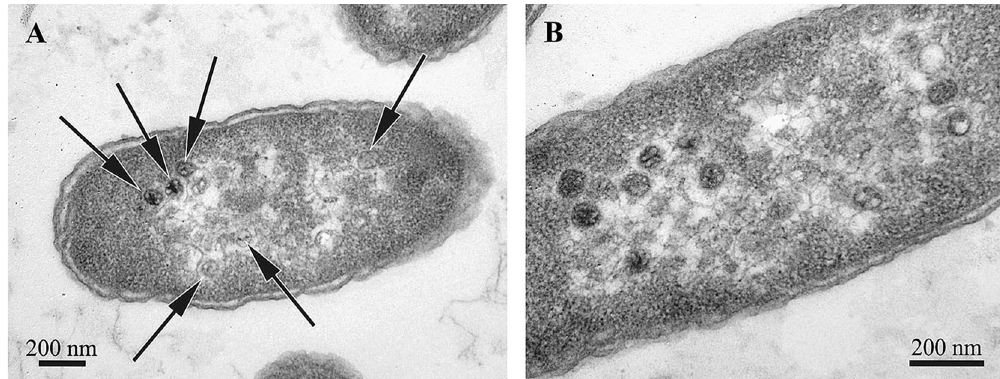
Figure 3. Thin sections of E. coli F5 cells infected by the bacteriophage RB49 (15 min post infection). Bacteriophage heads and proheads (both empty and partially filled) are visible (arrows on A ). Note that the capsids do not appear exactly uniform and the tails are not visible.